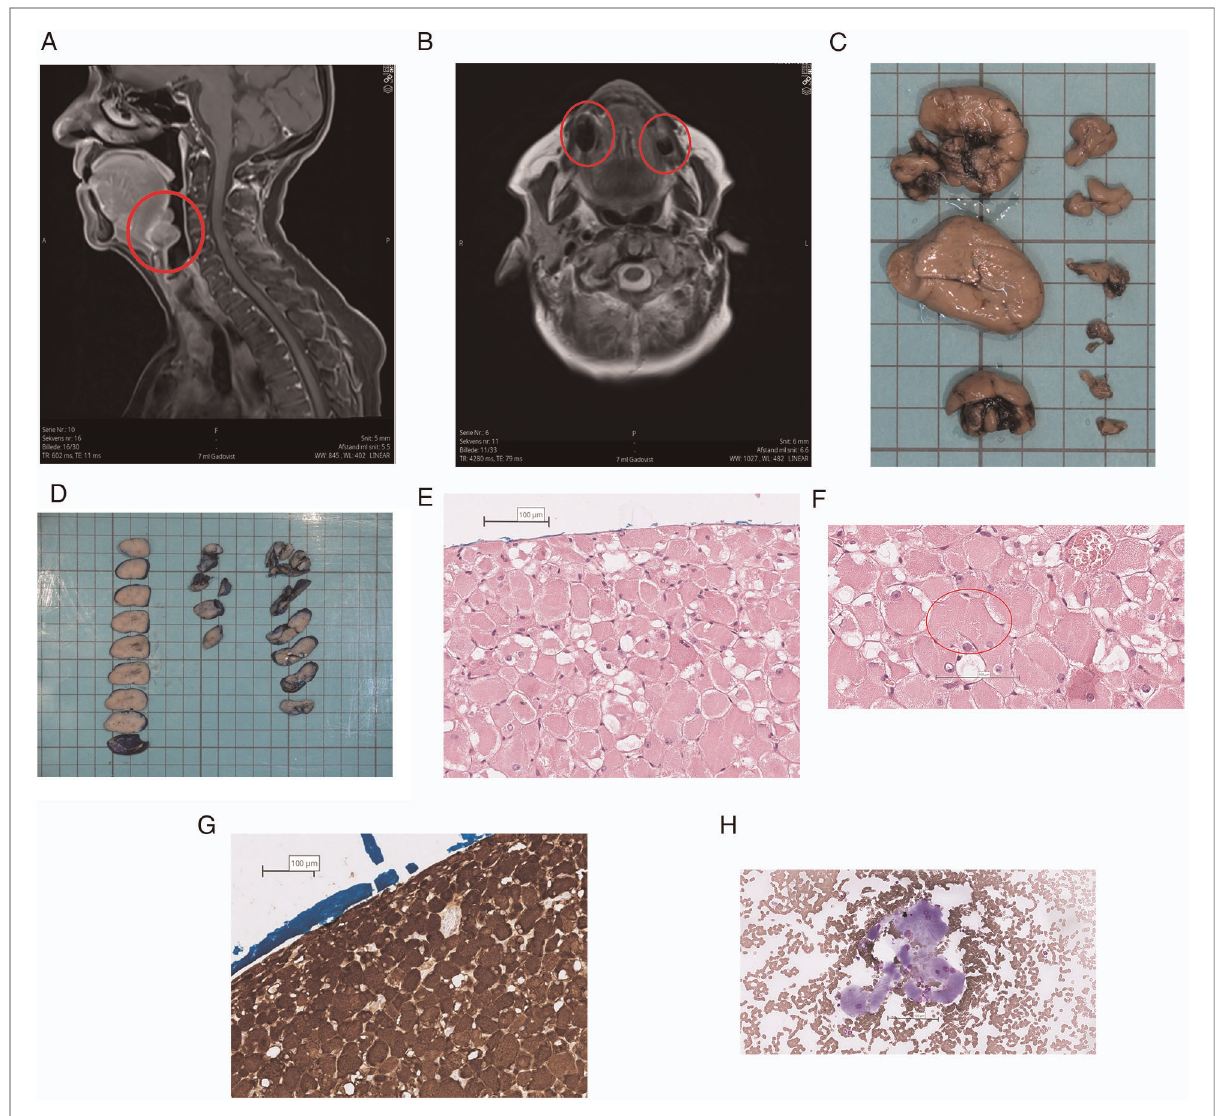
FIGURE 2 Text description: ( A ) MRI, T1, sagittal view. ARM marked with red circle. ( B ) MRI, T2, Axial view. ARM marked with red circle. ( C,D ) The specimen consisted of nine separate parts which had a diameter of 7 to 38 mm. The surface was well delineated and uniformly brown. The cut surface was solid and light brown with a few, small, darker areas. The surface of the largest tumors was stained blue before sectioning. ( E,F ) The growth pattern is solid and the tumor cells are large and polygonal with eccentric nuclei and abundant eosinophilic, granular and often vacuolated cytoplasm. The nuclei are rounded and uniform with light staining chromatin and a single nucleolus. Occasionally characteristic striations can be seen in the cytoplasm of the tumor cells. Stained with HE (Hematoxylin-Eosin). The scale bar is set at 100 µm. ( G ) The tumor cells show a strong cytoplasmic expression of Desmin by immunohistochemical staining, con fi rming the myogenic origin of the tumor. The scale bar is set at 100 µm. ( H ) The overall number of tumor cells in the specimen is sparse. The tumor cells are large (compared with adjacent erythrocytes) and have peripherally located nuclei with a single nucleolus and abundant, fi nely granular cytoplasm. Stained with MGG (Mey-Grünwald-Giemsa). The scale bar is set at 100